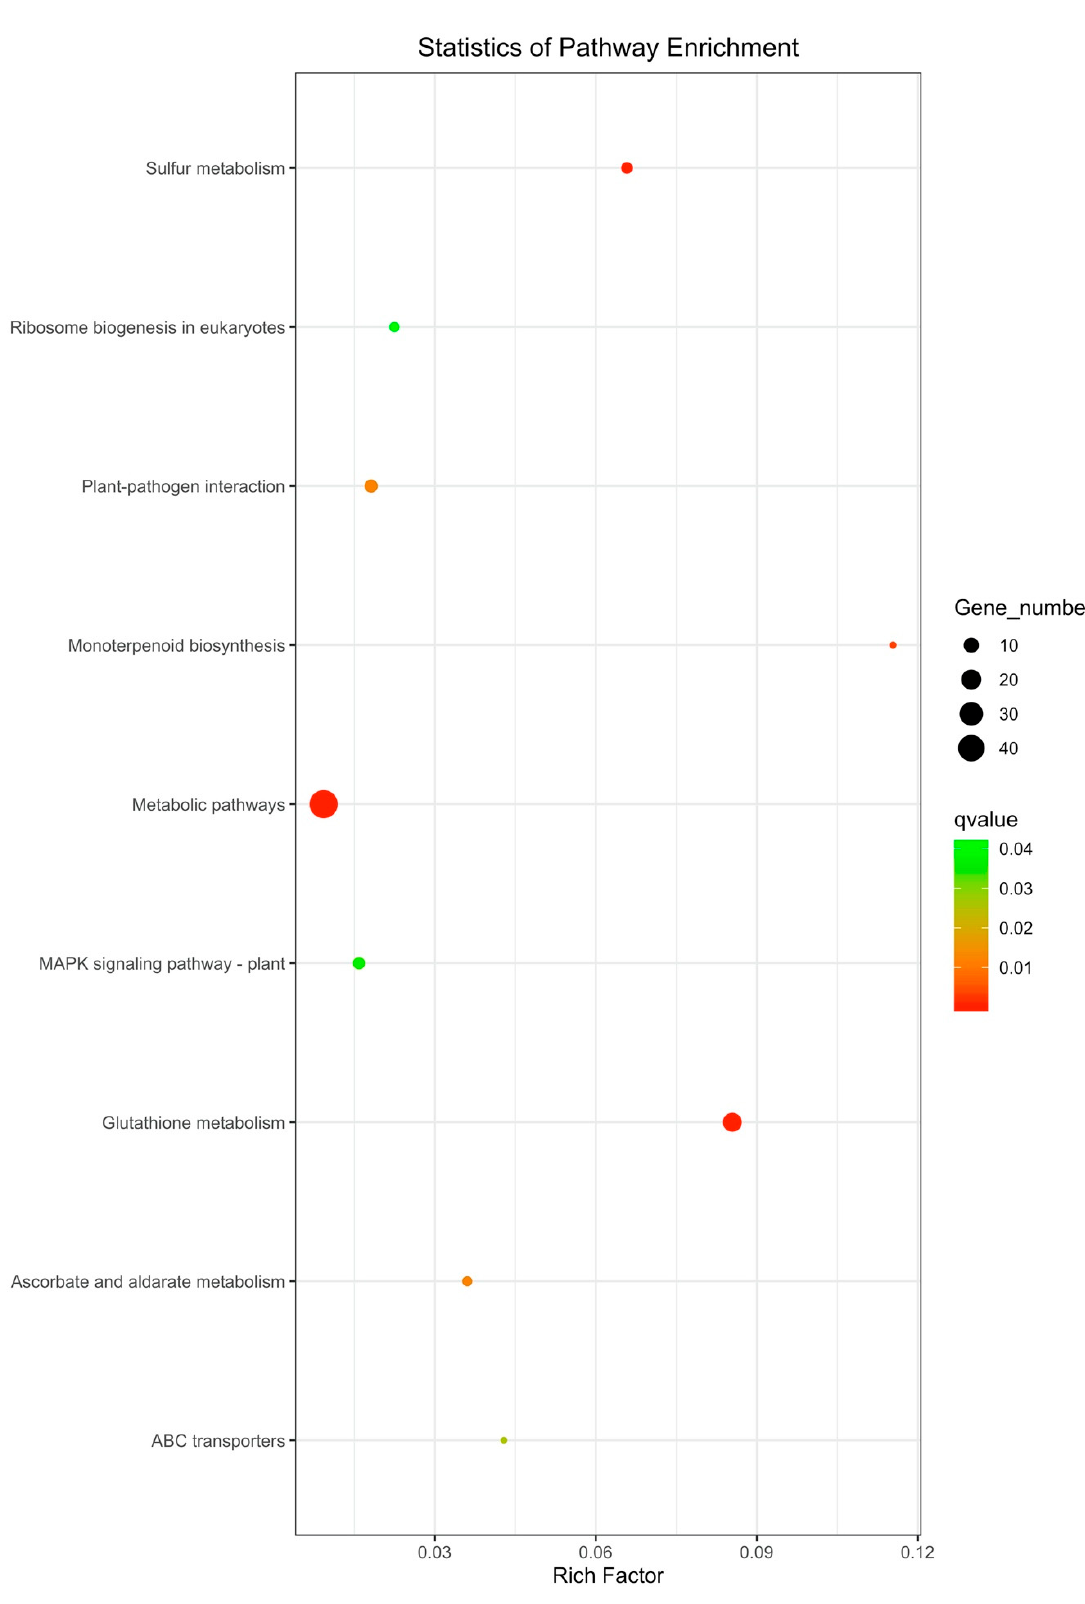
Figure 6. KEGG pathways enriched for down-regulated DEGs in K 326 Wz/Wz inoculated with the Wz-Wz isolate of P. nicotianae compared to inoculated Hicks. The y -axis indicates the name of the KEGG pathway. The dot size means the gene number. The dot color indicates the q -value.